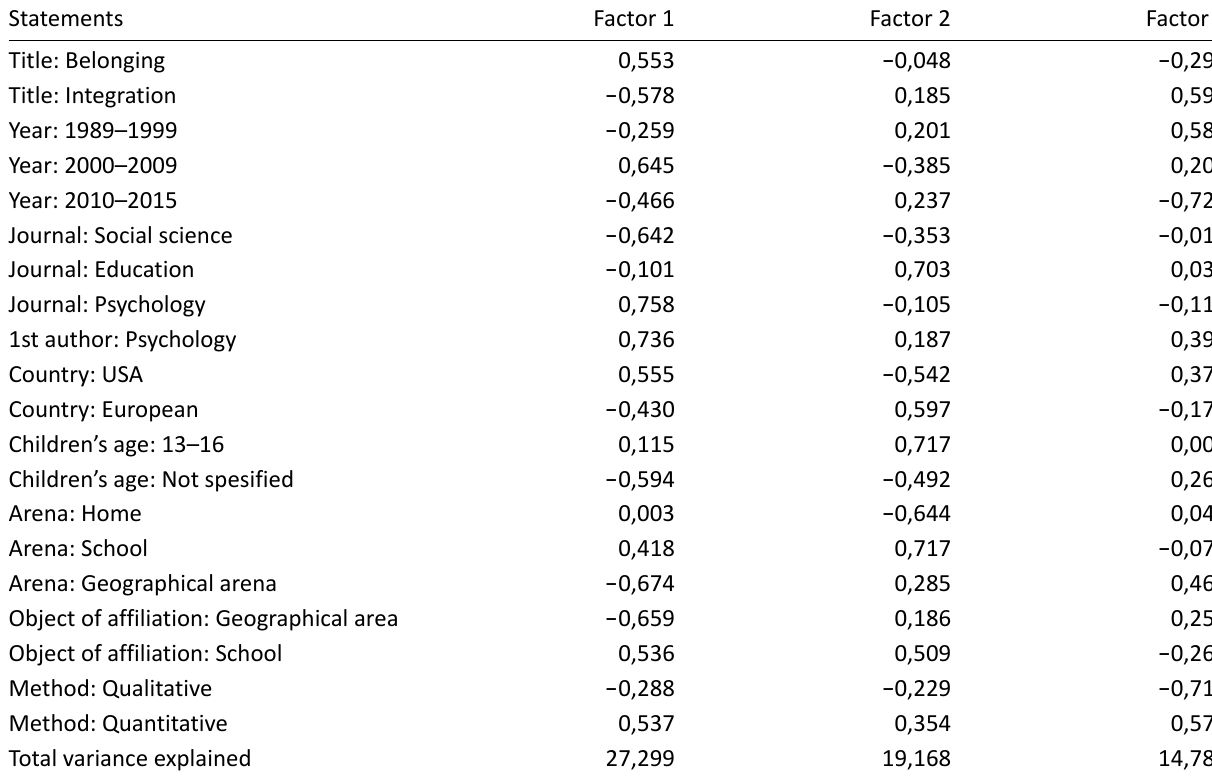
Table 4. Discourses of immigrant children’s connections (sample